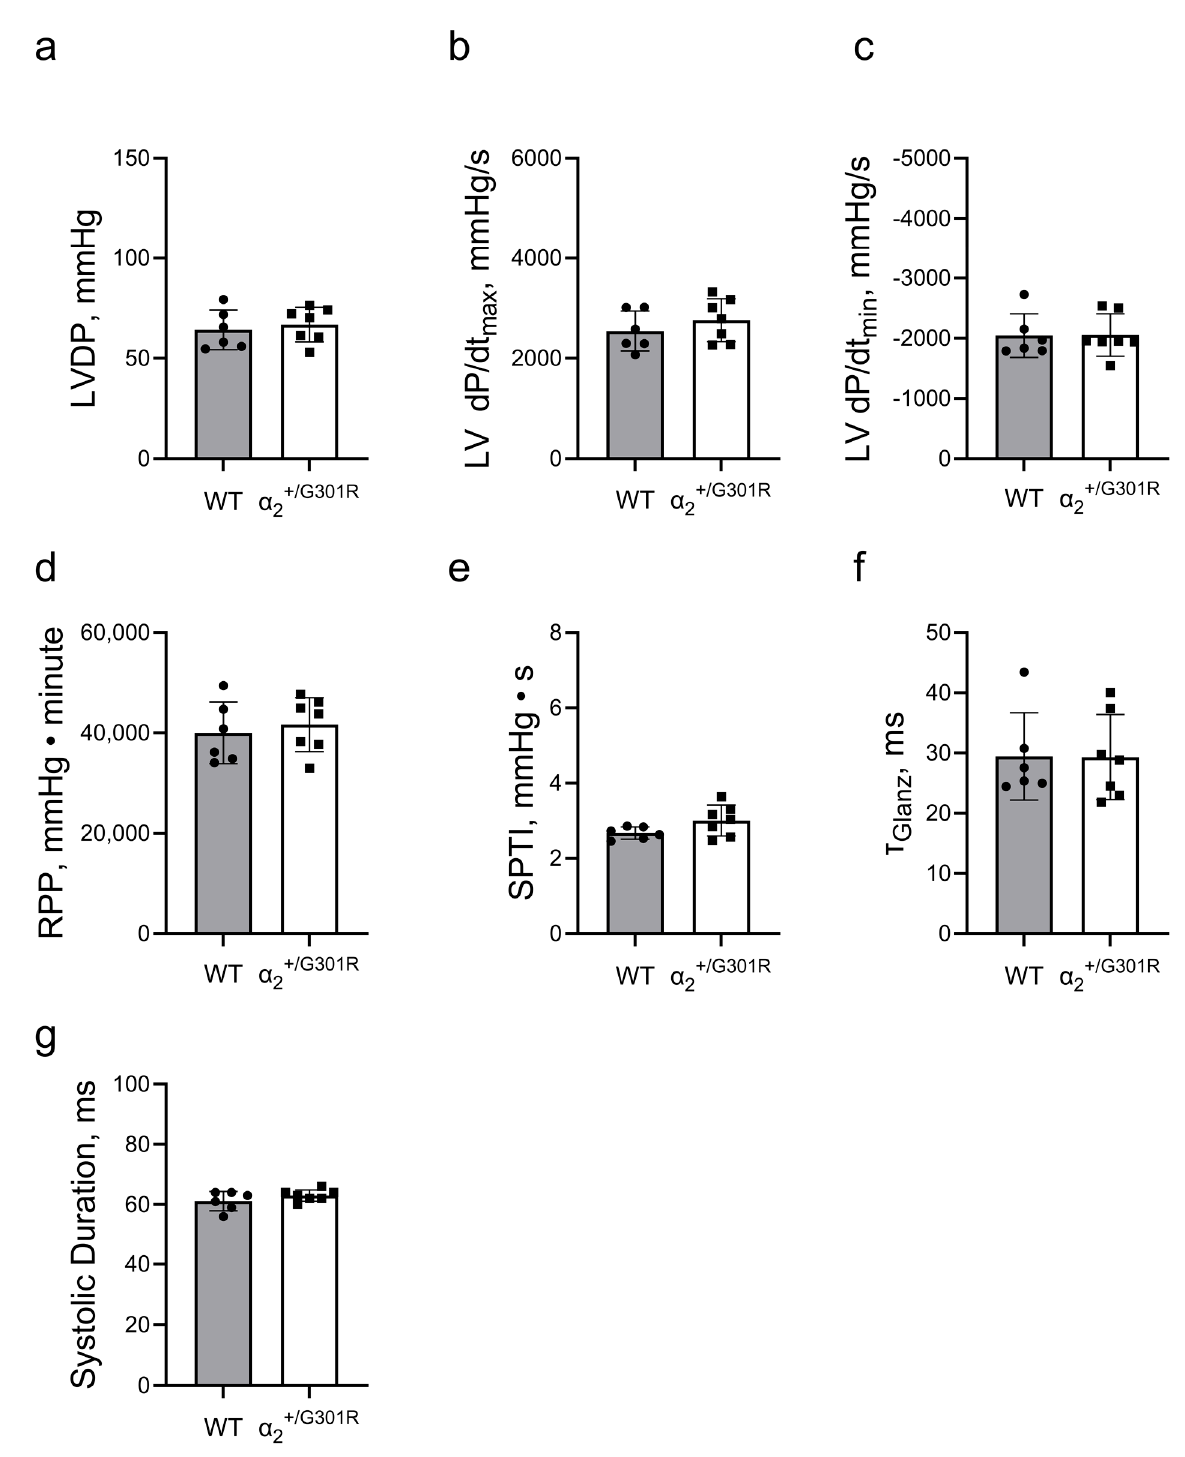
Figure 4. Differences in cardiac contractility between α 2+/G301R hearts and WT hearts were elim- inated during atrial pacing at 10.5 Hz (630 BPM). Cardiac variables including ( a ) left-ventricular- developed pressure (LVDP), ( b ) left ventricular dP/dt max (LV dP/dt max ), ( c ) left ventricular dP/dt min (LV dP/dt min ), ( d ) rate–pressure product (RPP), ( e ) systolic pressure–time index (SPTI), ( f ) τ Glanz , and ( g ) systolic duration were not different between α 2 +/G301R hearts and WT during atrial pacing. Data were compared with an unpaired t -test or a Mann–Whitney test. n =